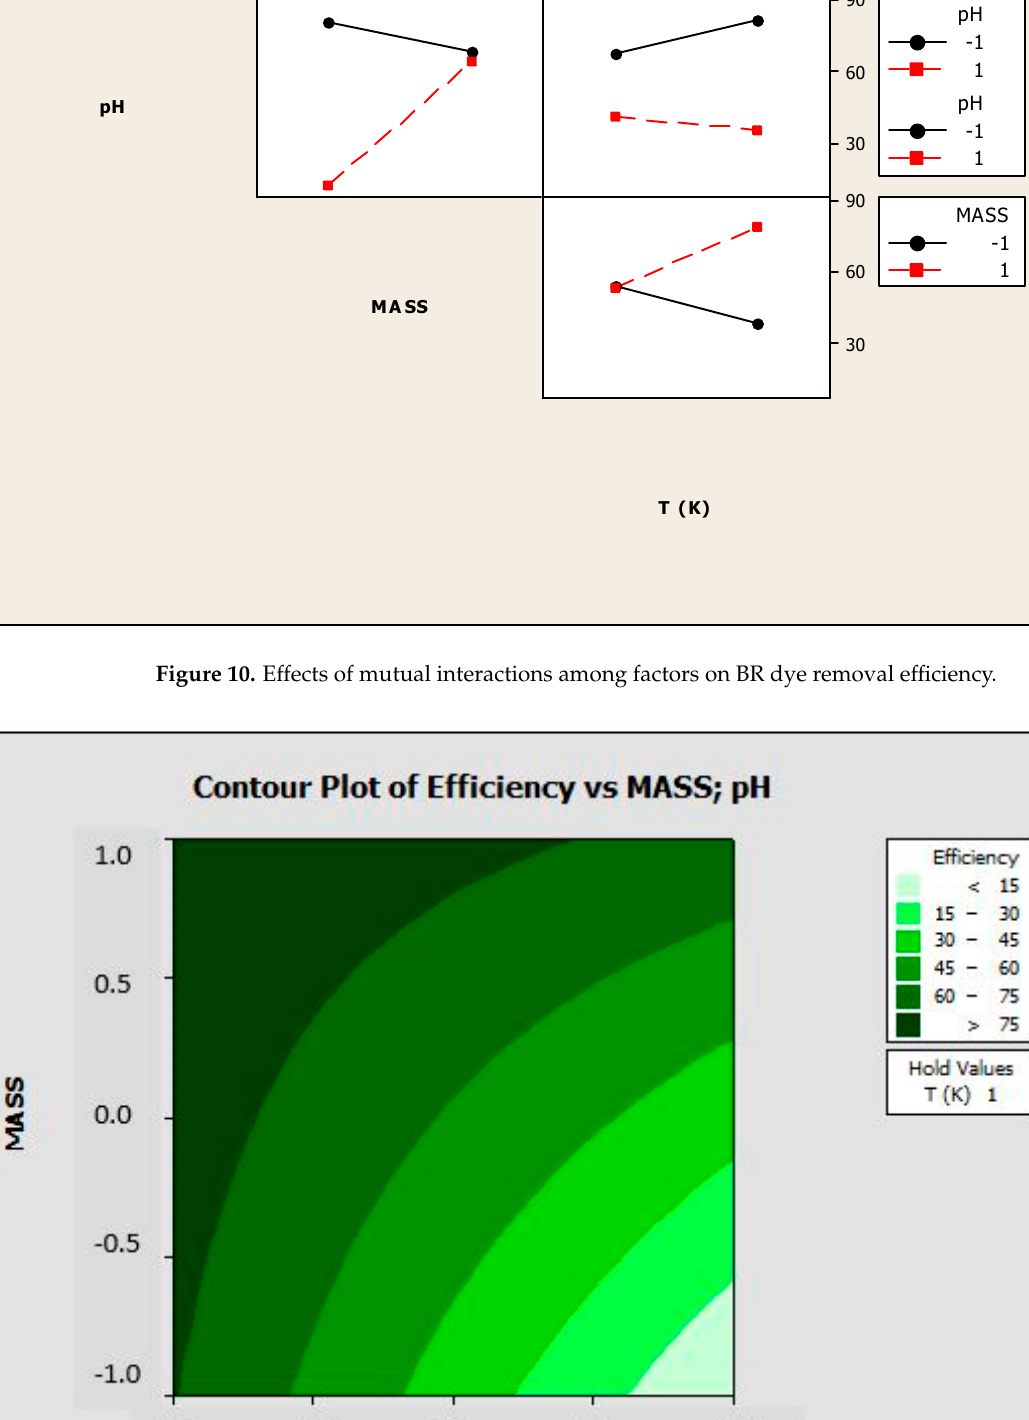
Figure 11. Contour plot of variation of efficiency as a function of mass and pH at T = 80 °C.